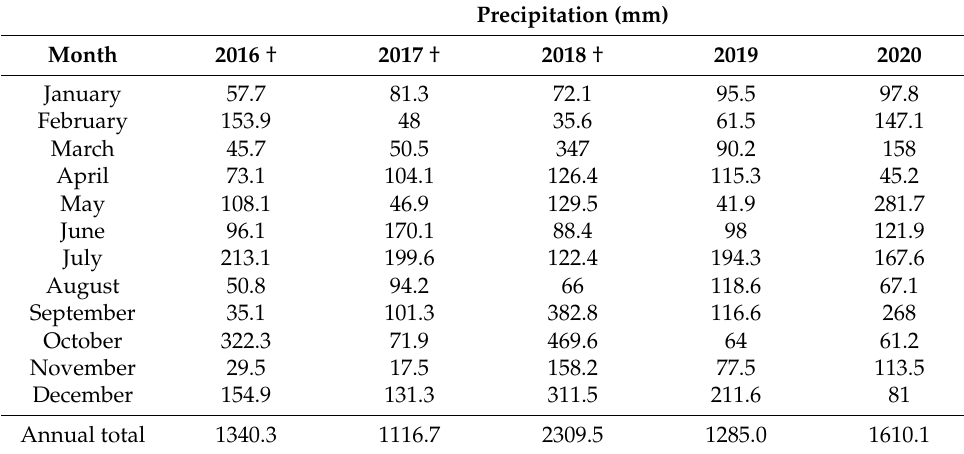
Table 3. Monthly and annual precipitation totals for study